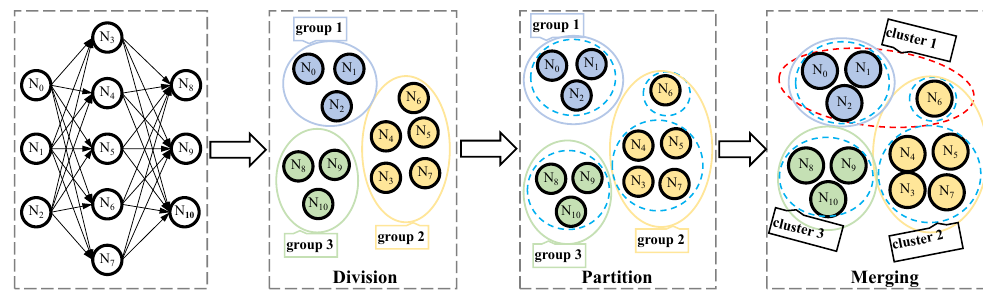
Figure 5. The topology-aware partitioning